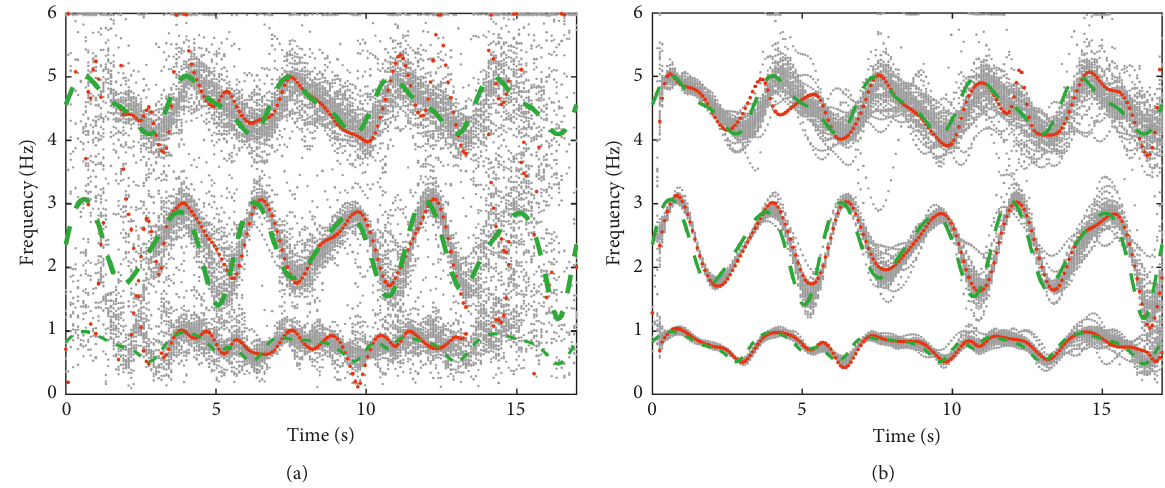
Figure 4: Natural frequency estimates by LS (a) and RR (b) for the TV numerical system with fast dynamic evolution (gray dots: natural frequency estimates from the 50 Monte Carlo tests; red dots: natural frequency estimates from the single test; green dashed lines: true values of natural